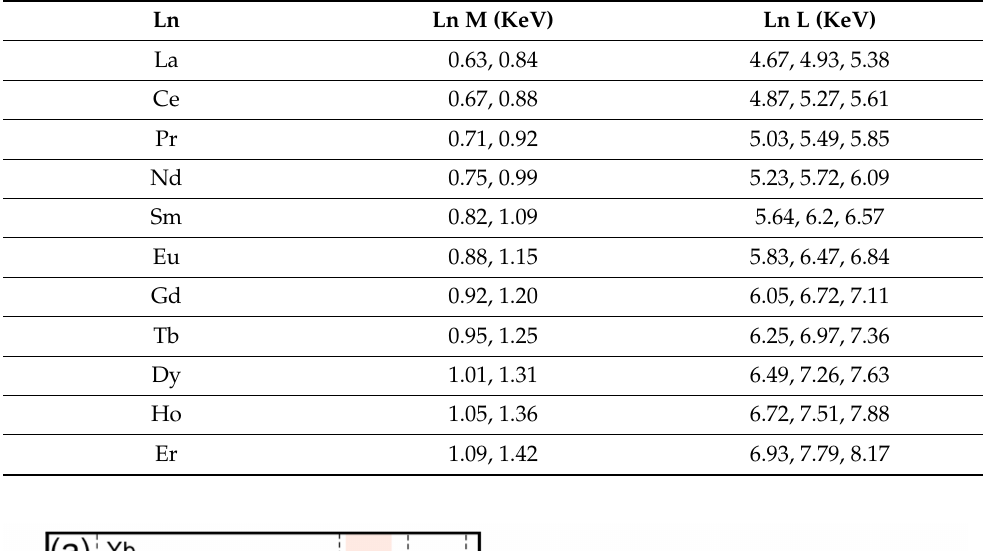
Table 1. EDXS (energy dispersive X-ray spectroscopy) Ln M and Ln L peak positions (KeV taken in